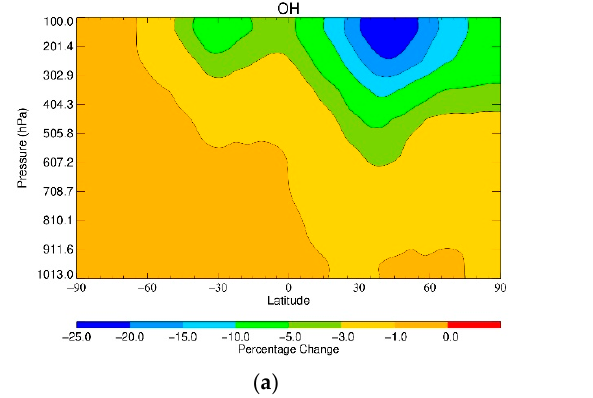
Figure 6. The percentage zonal change of OH from ( a ) STOCHEM-base to STOCHEM-75NO x scenario and ( b ) STOCHEM-base to STOCHEM-50NO x scenario. Note: The approximate height equivalent to the pressure in the y -axis can be found in Appendix A (Table A1).